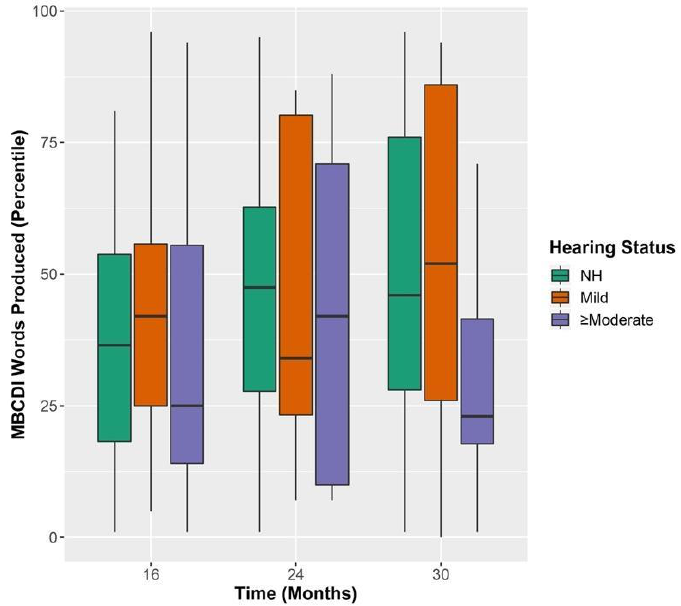
Figure 5. MBCDI performance over time. Note: Normal Hearing (NH); MacArthur-Bates Commu- nicative Development Inventories (MBCDI); MBCDI performance over time (16, 24, and 30 months) as a function of hearing status (normal hearing in green, mild in orange, and ≥ moderate in purple). Box plot represents the minimum, first quartile, median, third quartile and maximum. Dots represent participants’ 2.70 standard deviations or more from the mean.